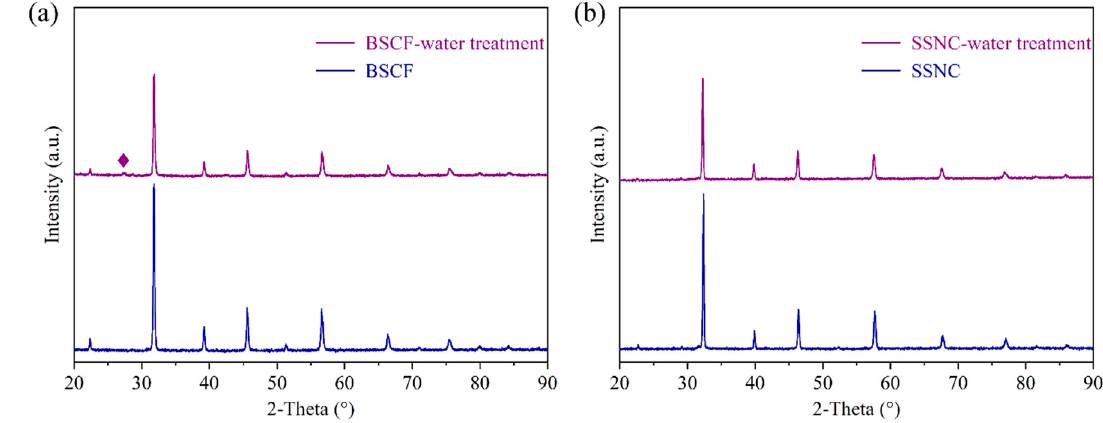
Figure 5. XRD patterns of the oxygen electrodes before and after 10% H 2 O-Ar treatment at 750 °C (cid:117) Ba(OH) for 5 h: ( a ) BSCF; ( b ) SSNC.  Ba(OH) 2 impurity. 5 h: ( a ) BSCF; ( b ) SSNC. 2 impurity.